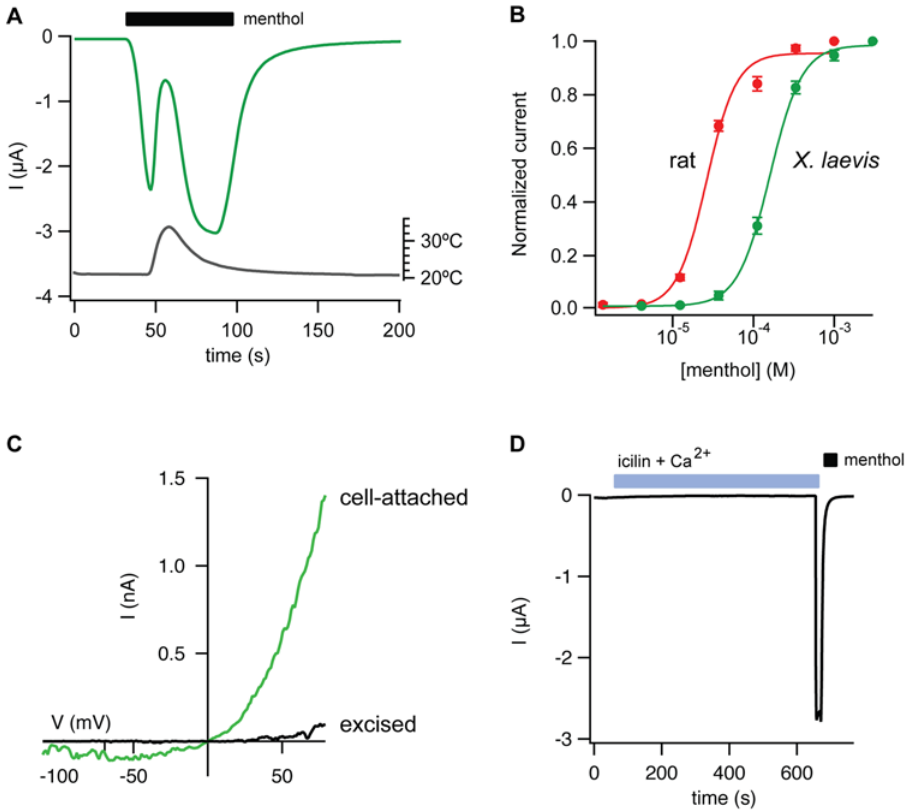
Figure 4. X.laevis TRPM8 is activated by menthol but not icilin. ( A ) In oocytes expressing xlTRPM8, application of menthol (1 mM) evoked inward currents (green trace) that were suppressed by a rise in bath temperature (gray trace). Holding potential was 2 60 mV. ( B ) Cell-attached patches from oocytes expressing xlTRPM8 (n=4) but not uninjected oocytes (n=3) displayed a strongly rectifying current (green trace) when the pipette solution contained 500 m M menthol. Formation of the inside-out configuration resulted in rapid current rundown (black trace, 90 seconds after patch excision.) ( C ) Concentration-response relation for menthol-evoked currents (at + 80 mV) from rat (red) or X. laevis (green) TRPM8- expressing oocytes. ( D ) Application of 10 m M icilin in the presence of 2 mM extracellular Ca 2 + failed to activate xlTRPM8, while 1 mM menthol evoked robust inward currents.